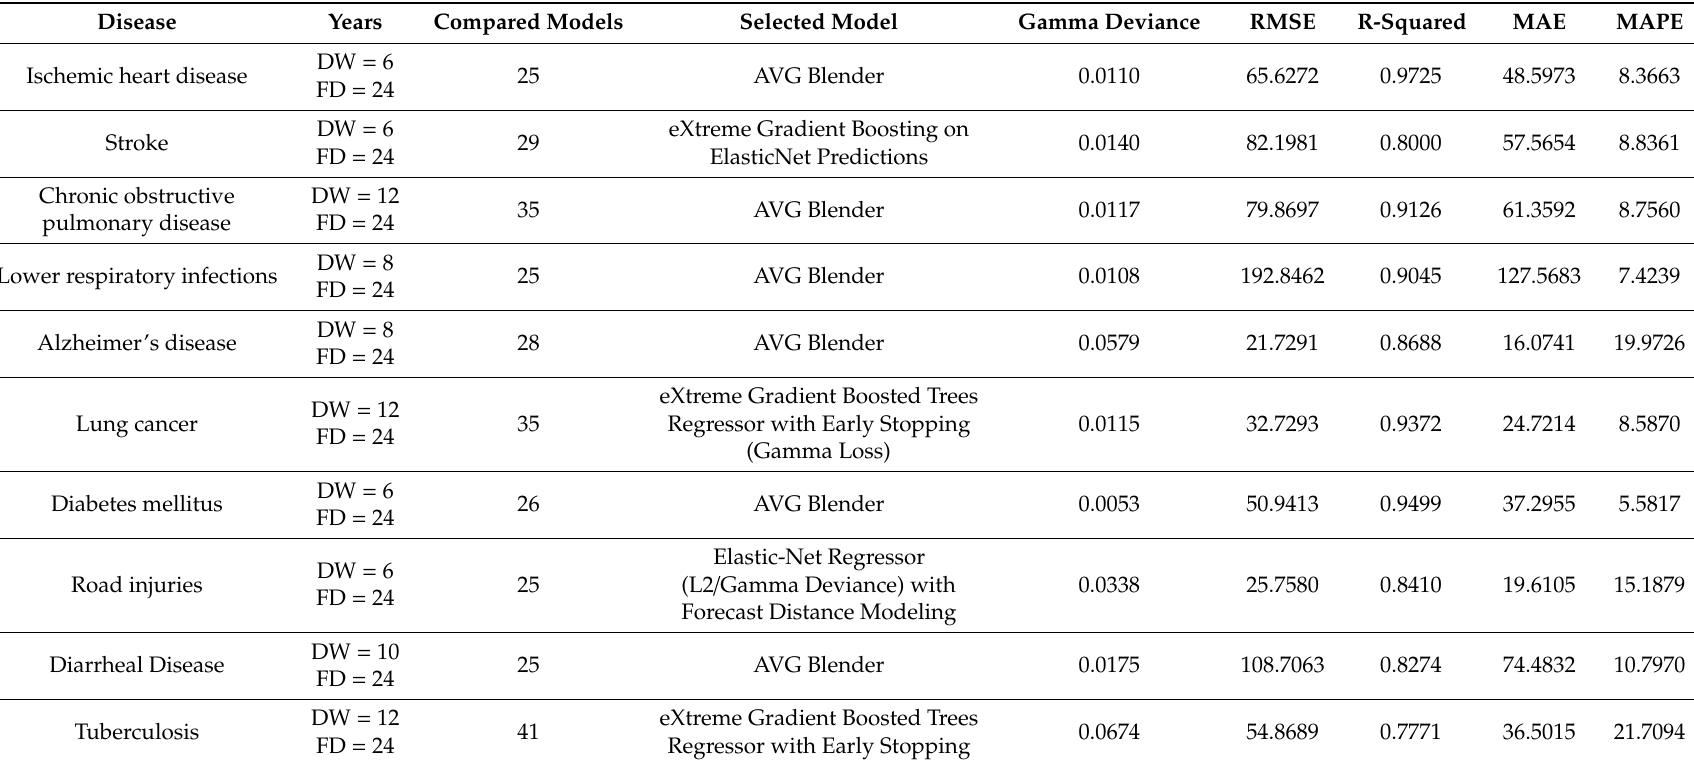
Table 1. Selected model performance validation based on